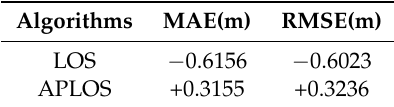
Table 9. MAE and RMSE fluctuations relative to u = 1 m/s.